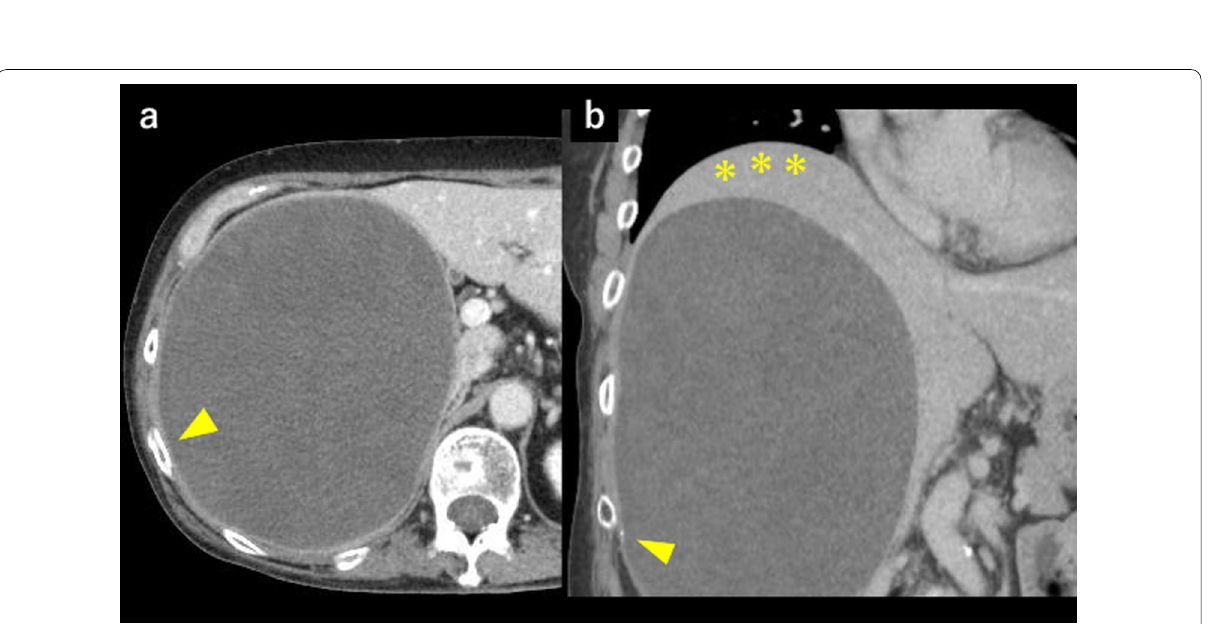
Fig. 2 Contrast-enhanced CT (portal vein phase). a Huge mass with low absorption occupied most of the right lobe of the liver, which had focal enhancement on the tumor margin. An old right 9th rib fracture was observed (arrow). b Fine calcification was observed at the tumor margin (arrow). The right diaphragm was elevated due to the tumor